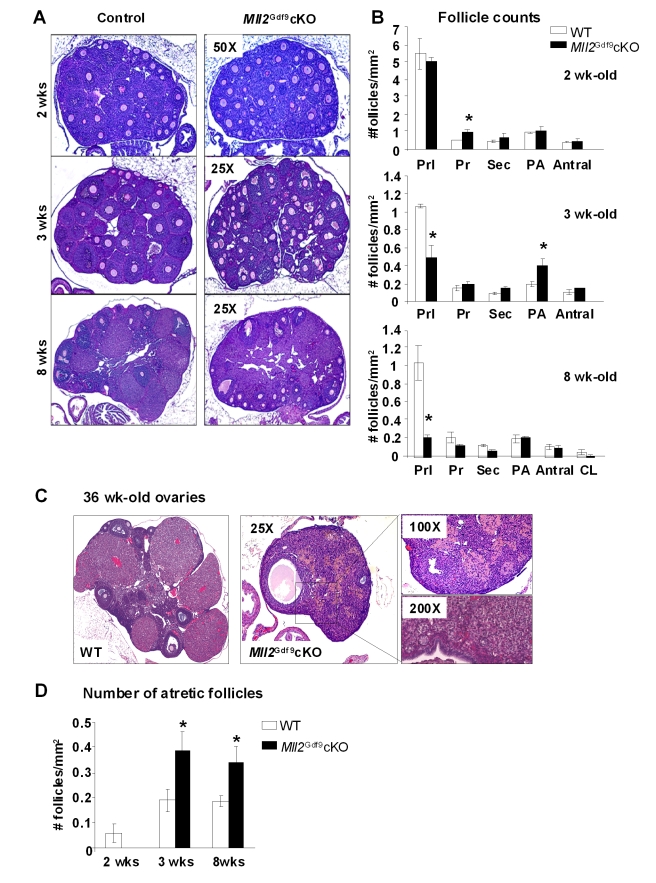

Mll2Gdf9 cKO females show increased ovarian follicular recruitment and loss.(A) PAS-stained ovaries from 2-, 3-, and 8-wk-old mice; the number of follicles was greatly reduced in ovaries from 8-wk-old Mll2Gdf9 cKO mice. (B) Follicle counts from 2-, 3-, and 8-wk-old mice. At 2 wk, Mll2Gdf9 cKO ovaries showed significantly increased (ANOVA test, * p<0.05) primary follicles (Pr), whereas 3-wk-old Mll2Gdf9 cKO ovaries showed significantly reduced primordial follicles (Prl) and increased preantral follicles (PA) (ANOVA test, * p<0.05). Mll2Gdf9 cKO ovaries from 8-wk-old mice showed further reduction in Prl follicles (ANOVA test, * p<0.05). Means of follicle counts corrected by surface area ± S.E. are shown (ovarian sections from five individual females were used; n = 5). Abbreviations: Prl, primordial; Pr, primary; Sec, secondary; A, antral; CL, corpora lutea. (C) Mll2Gdf9 cKO ovaries from 36-wk-old mice stained with hematoxylin-eosin showed very few follicles (boxed area). (D) From 3 wk onwards, the number of atretic follicles was significantly higher in Mll2Gdf9 cKO ovaries, compared to controls. Means of follicle counts corrected by surface area ± S.E. are shown (ovarian sections from five individual females were used; n = 5). ANOVA test, * p<0.05.